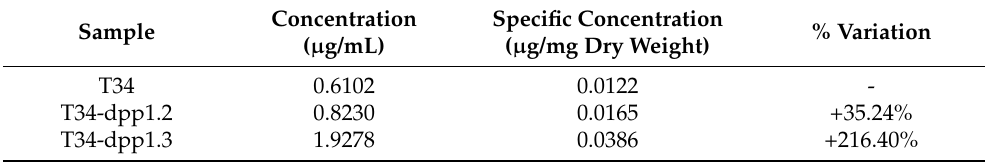
Table 2. Quantification of farnesol from 24 h grown mycelia.